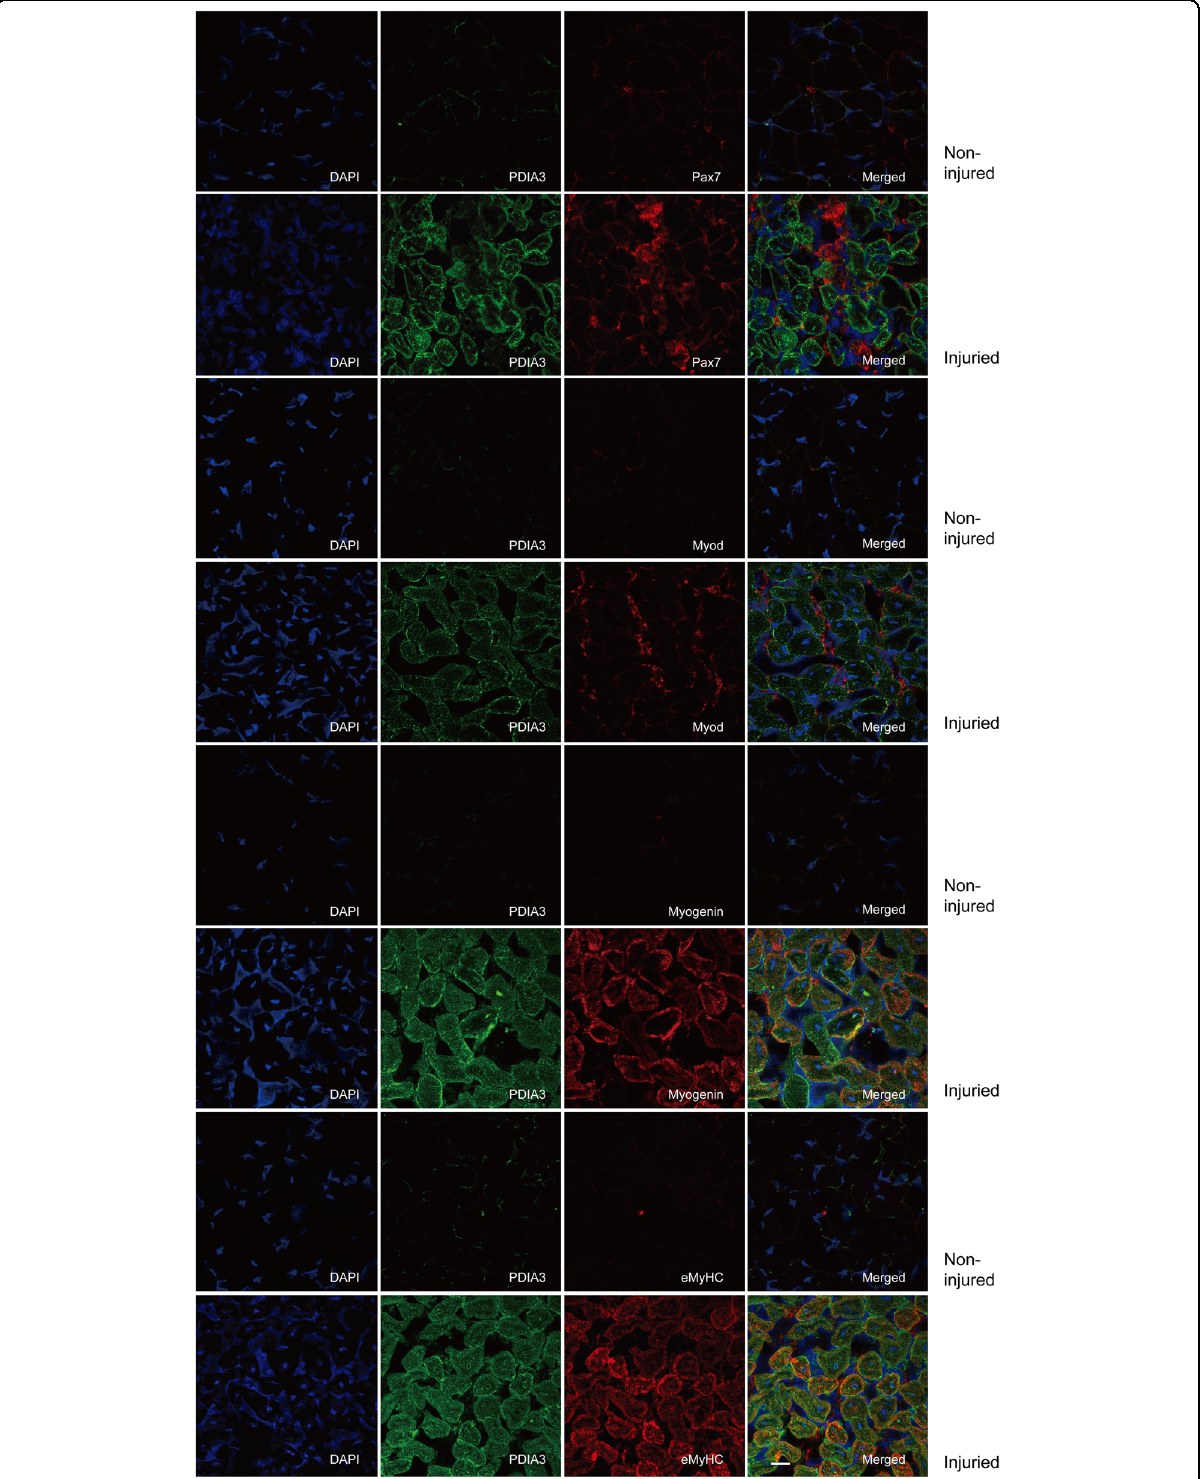
Fig. 2 Expression of PDIA3 in activated SCs during muscle regeneration. The gastrocnemius muscle in mice was injured by the direct injection of 100µl CTX (10µM). On day 7 post injury, the gastrocnemius muscle was harvested from euthanized mice. Frozen sections of gastrocnemius muscle were subjected to the immuno fl uorescence costaining of PDIA3 with Pax7, Myod1, myogenin, and eMyHC. The staining of Pax7 was performed to identify SCs; the staining of Myod1 was used to identify activated SCs that had undergone differentiation. The staining of myogenin was performed to identify mature myotubes. The staining of eMyHC was used to identify regenerated myo fi bers. The cell nuclei were stained with DAPI. Scale